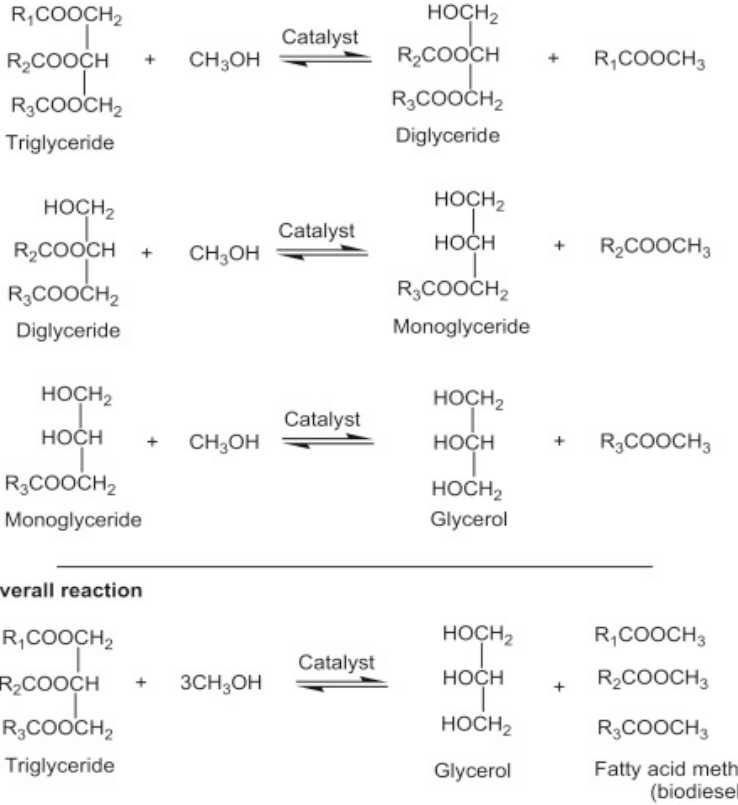
Figure 4. Transesterification reaction equation.